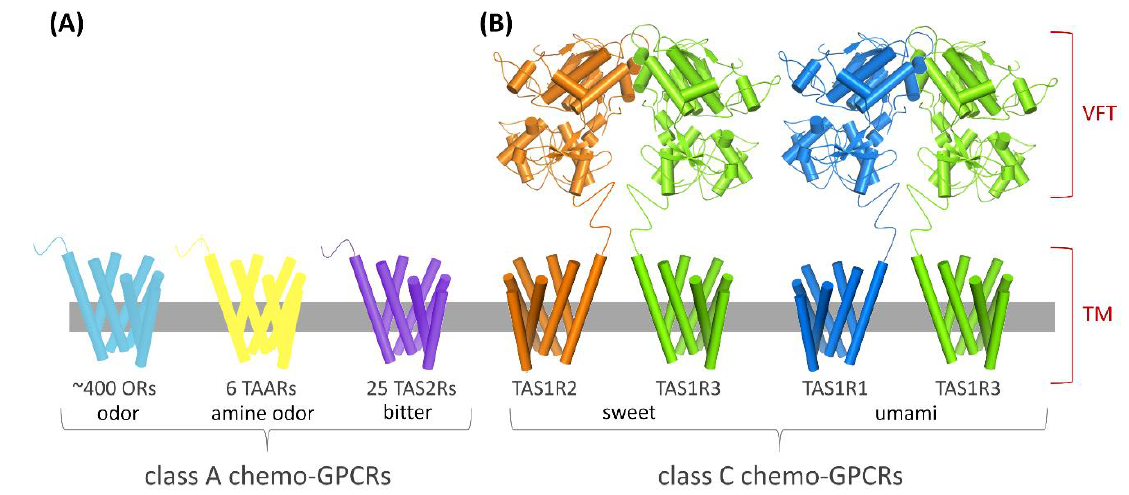
Figure 1. Architecture of csGPCRs. ( A ) Chemosensory receptors classified as class A G protein-coupled receptors (GPCRs), whose orthosteric binding site is located inside the TM domain, i.e., ORs, TAARs and TAS2Rs. ( B ) Chemosensory receptors classified as class C GPCRs, whose orthosteric binding site is located in the Venus flytrap (VFT) domain, i.e., TAS1R2/TAS1R3 and TAS1R1/TAS1R3.